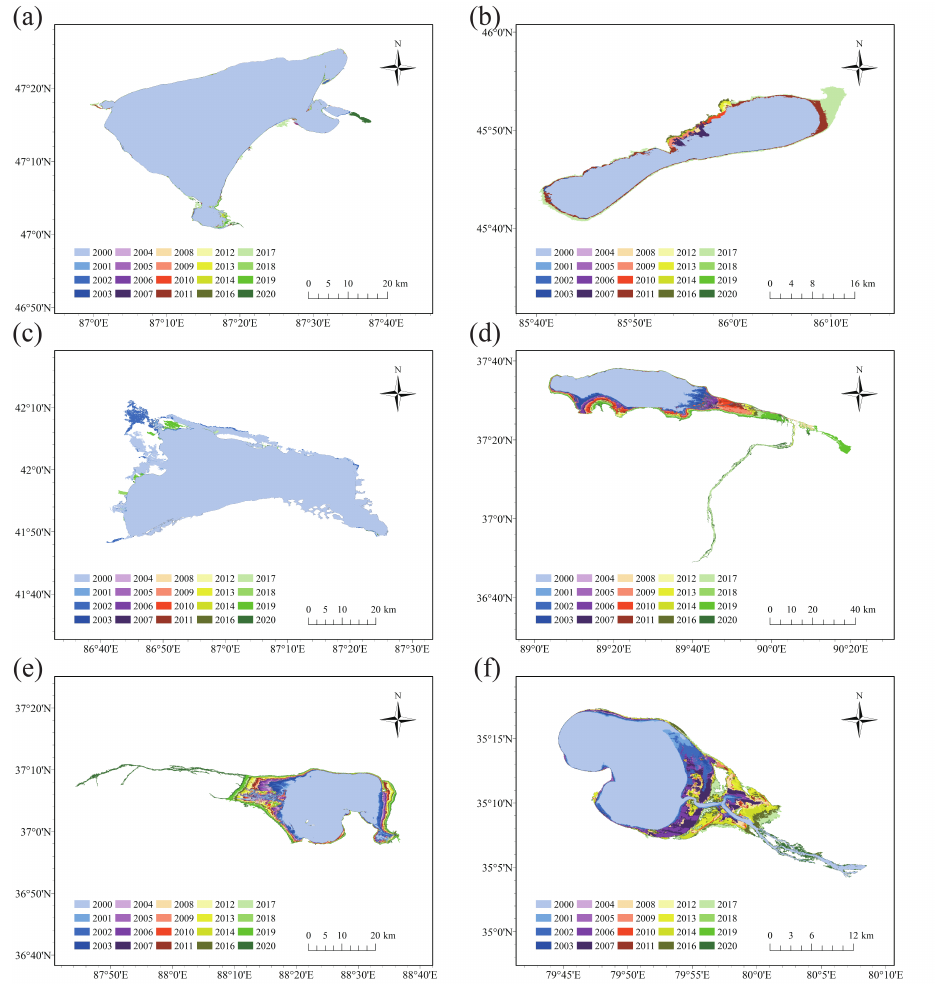
Figure 4. Variation of lake area from 2000 to 2020 ( a ) Ulungur Lake; ( b ) Manas Lake; ( c ) Bosten Lake; ( d ) Ayakkum Lake; ( e ) Aqqikkol Lake; ( f ) Aksayquin Lake.